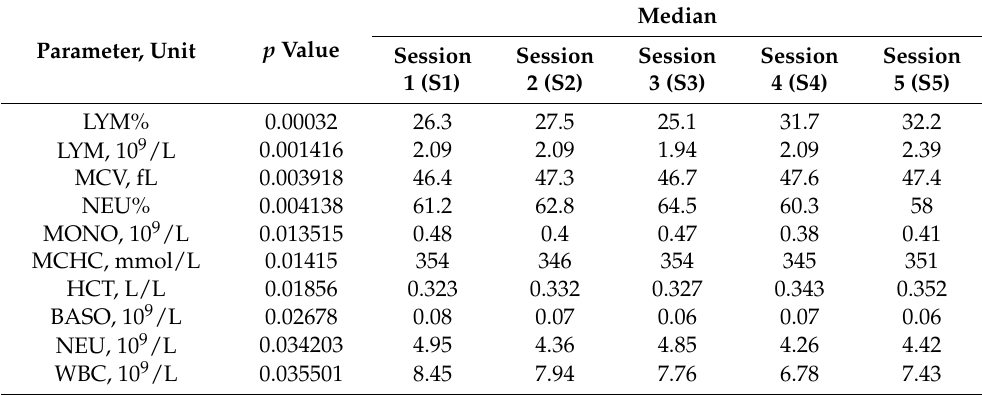
Table 2. Results of Friedman’s ANOVA and post hoc test for morphological analysis for the supple- mented